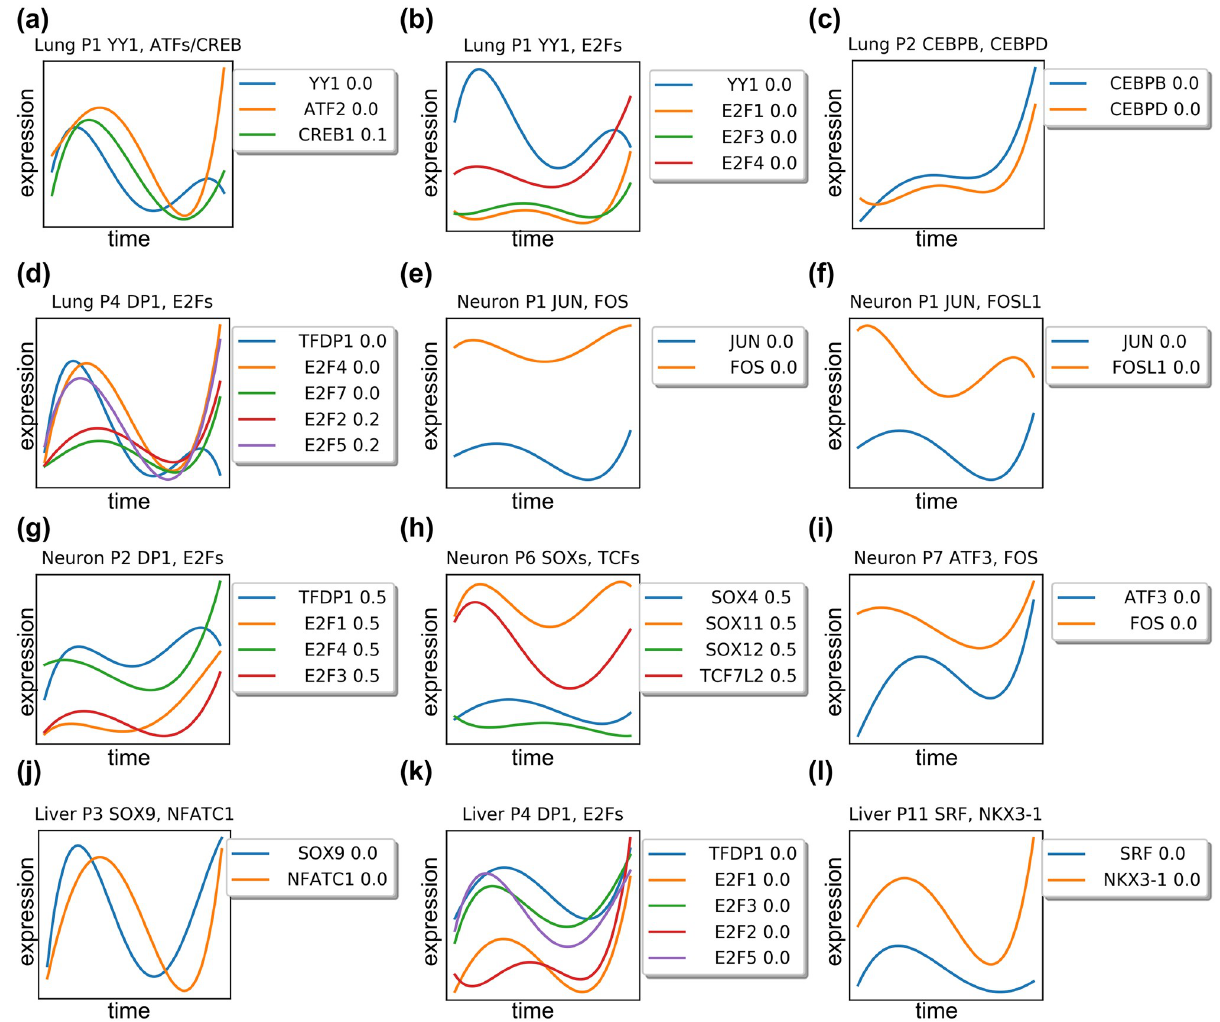
Fig 4. Expression profiles for top TFs assigned by the method to the lung, neuron, and liver reconstructed models. Each figure plots the expression TFs predicted to co-regulate a specific path. Each figure legend denotes the color and the time assignment for each TF. Profiles for TFs are the MLE estimates for these TFs expression values based on learned model parameters. (a-d) co-regulating TF expressions in lung paths. (e-i) co-regulating TF expressions in neuron paths. (j-l) co-regulating TF expressions in liver paths. See text for